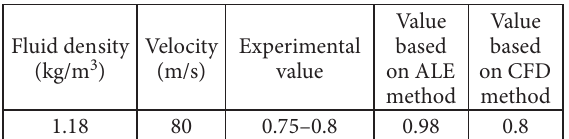
Table 6. Drag characteristics